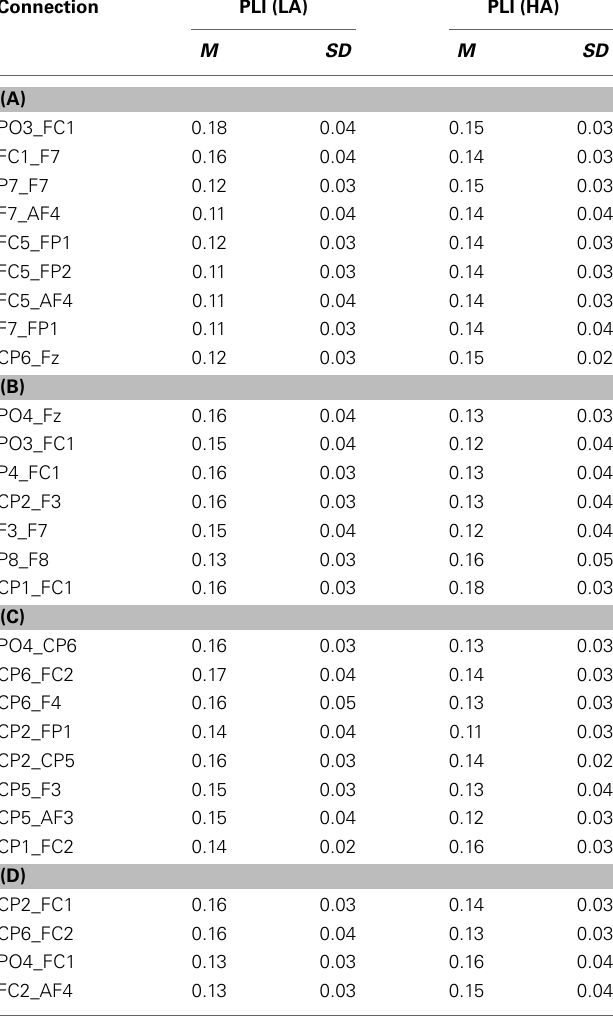
Table 2 | Results of one-sample t -tests for dPLI values during high (HA) and low experiences of agency (LA) in trials in which (A) goals matched the outcomes, (B) goals mismatched the outcomes, (C) primes matched the outcomes, and (D) primes mismatched the outcomes in broadband frequency.